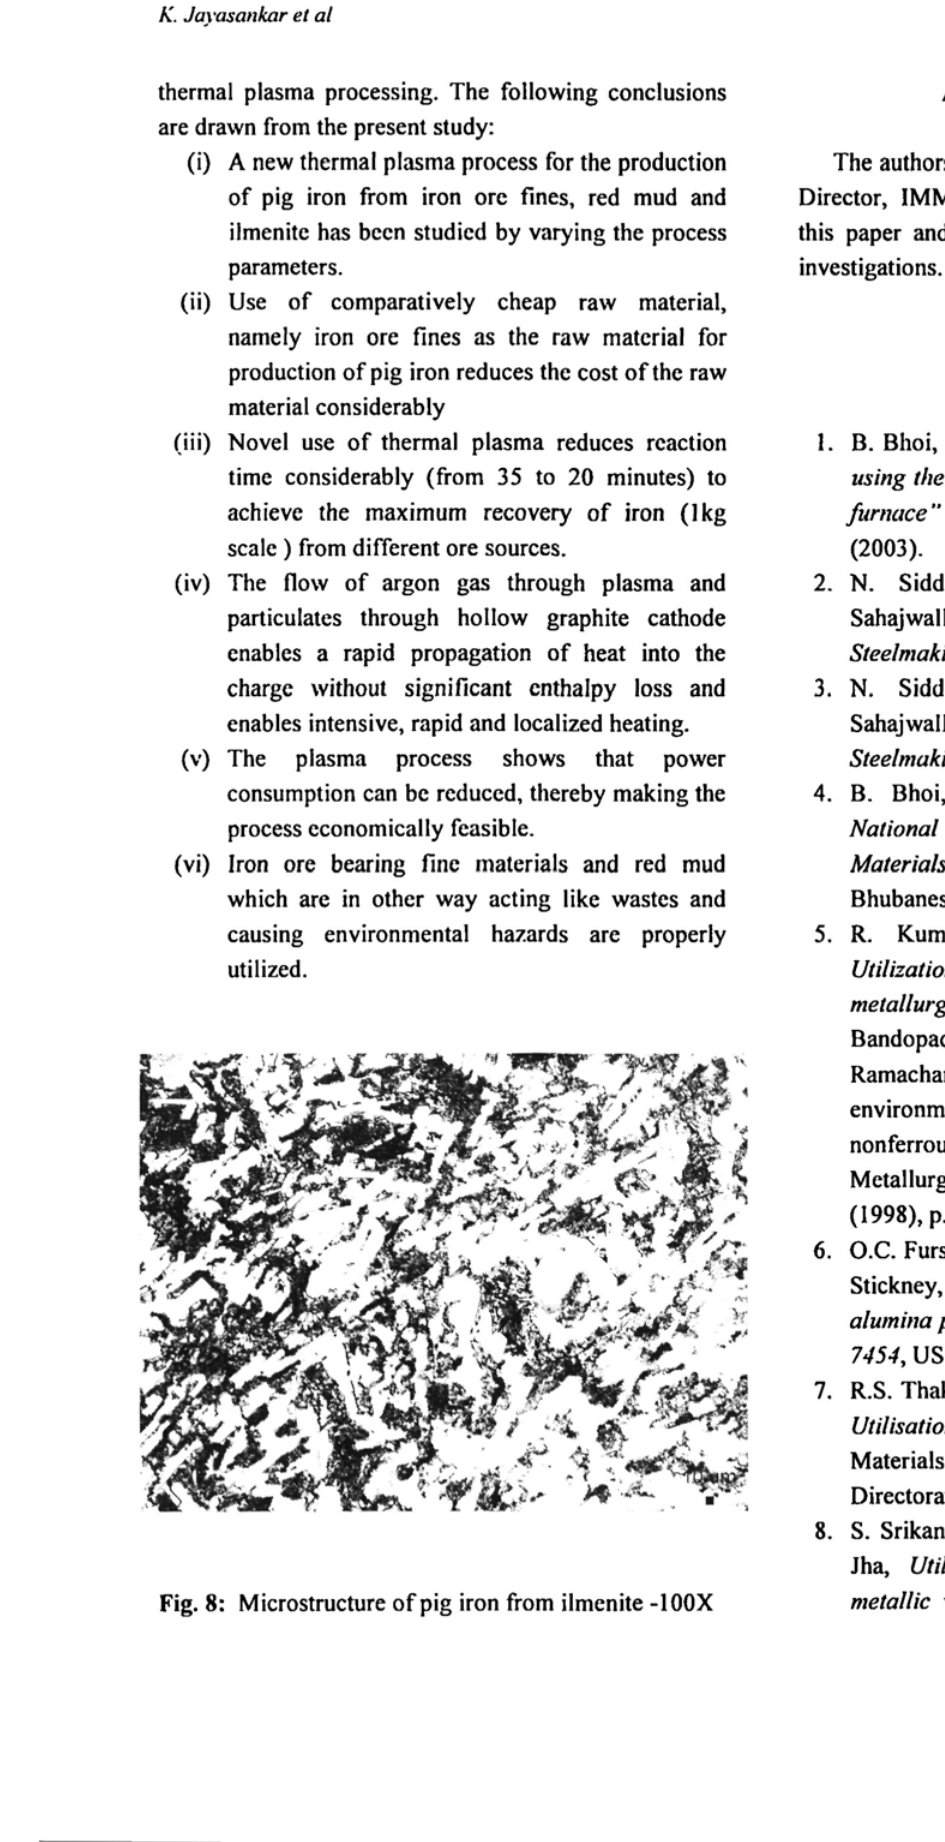
Fig. 8: Microstructure of pig iron from ilmenite